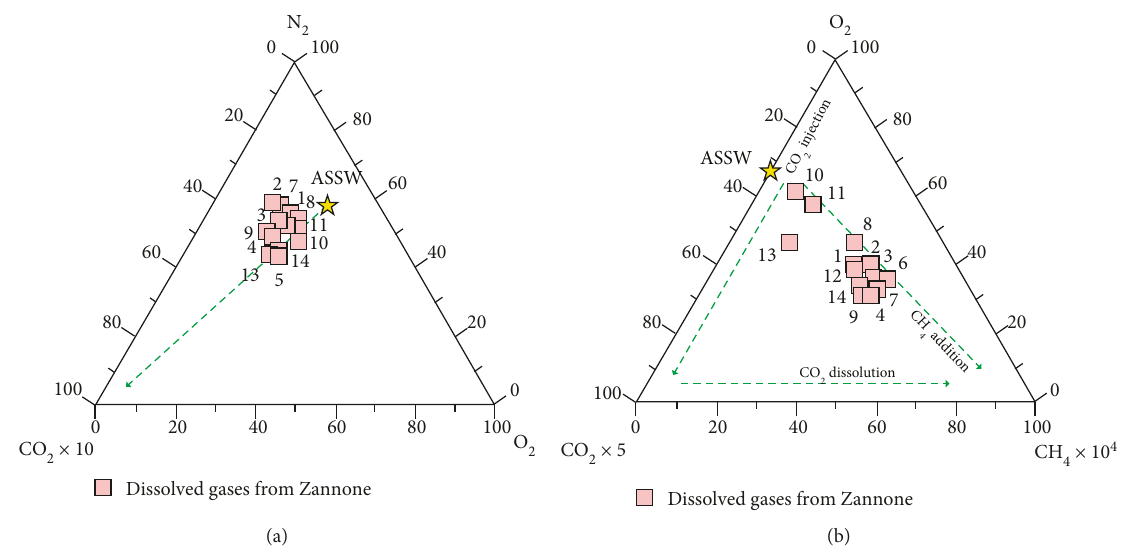
Figure 5: Geochemical relationships for dissolved gases. The star indicates the ASSW (air-saturated seawater). (a) The relative concentrations , O , and N . The dashed line indicates a trend of CO injection in an ASSW; (b) relative concentrations CH of CO 2 2 2 2 Volcanic/hydrothermal-derived components (CO -CH ) are plotted together with a typical dissolved atmospheric component (O 2 4 dashed lines represent trends of CO and CH injection and CO dissolution due to 2 4 2